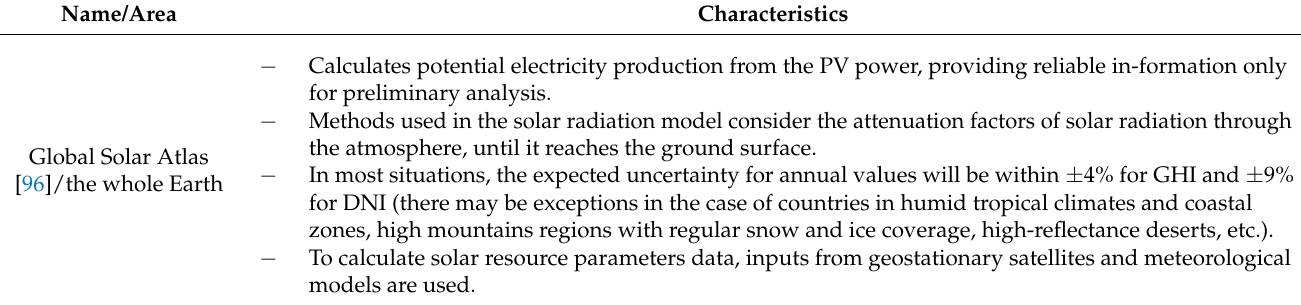
Table 4. Characteristics of selected solar